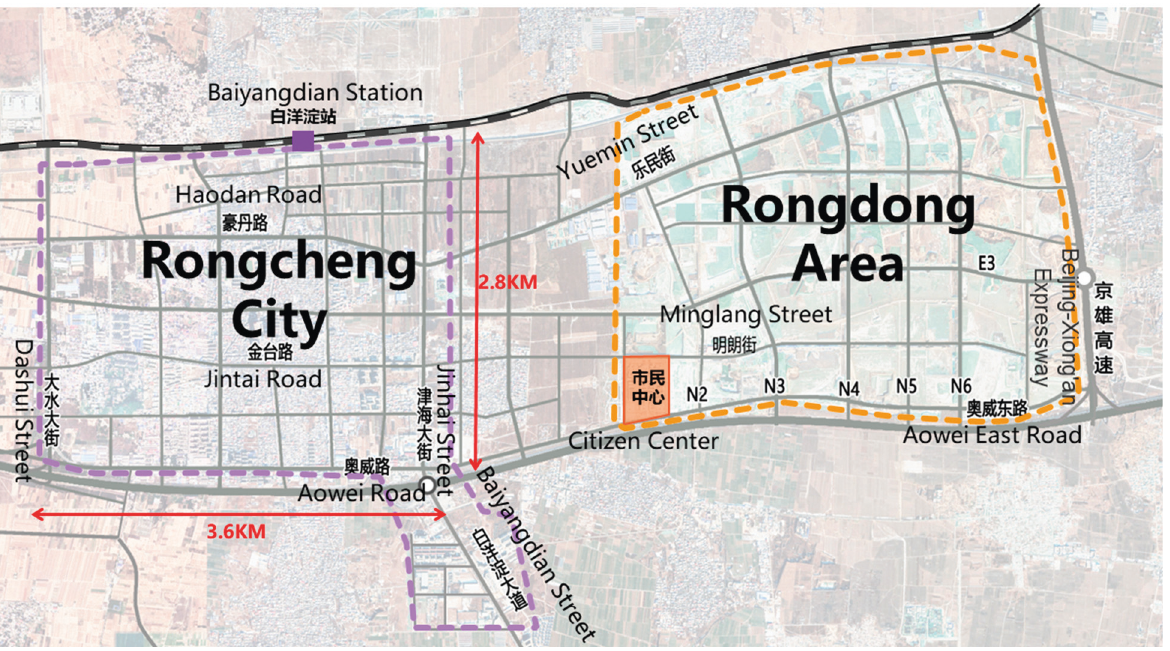
Figure 1: Operation area of Xiong’an DR